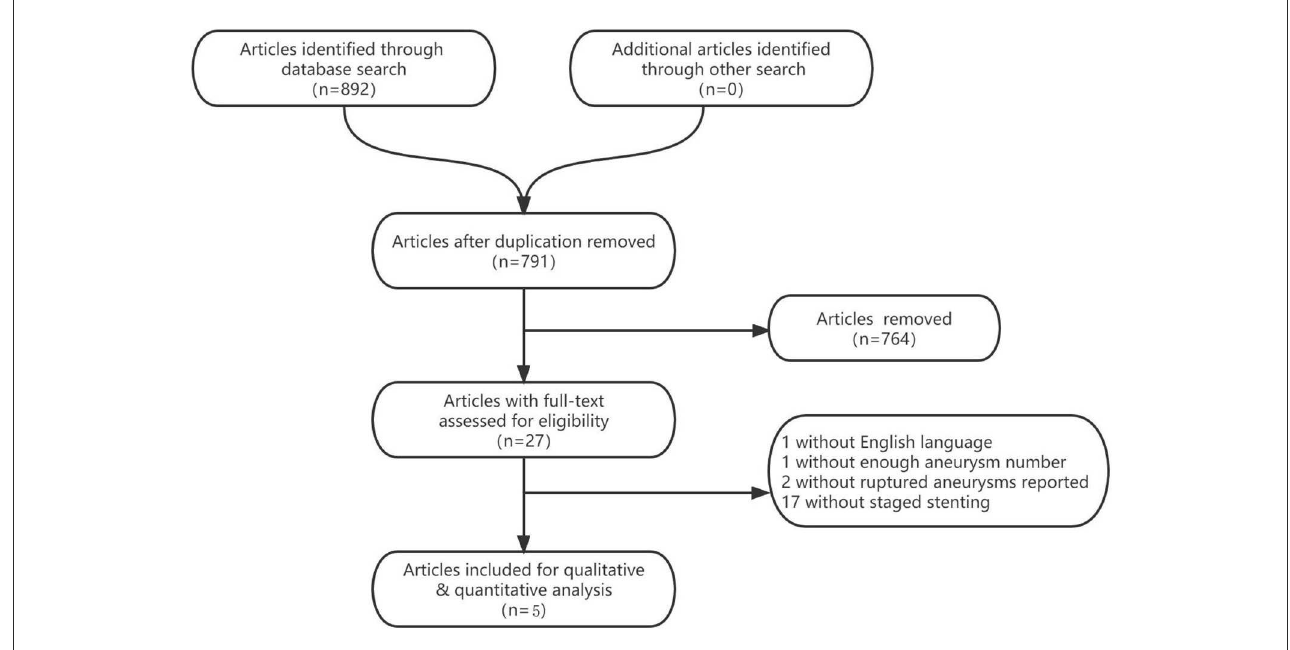
FIGURE1 Flowchart of study